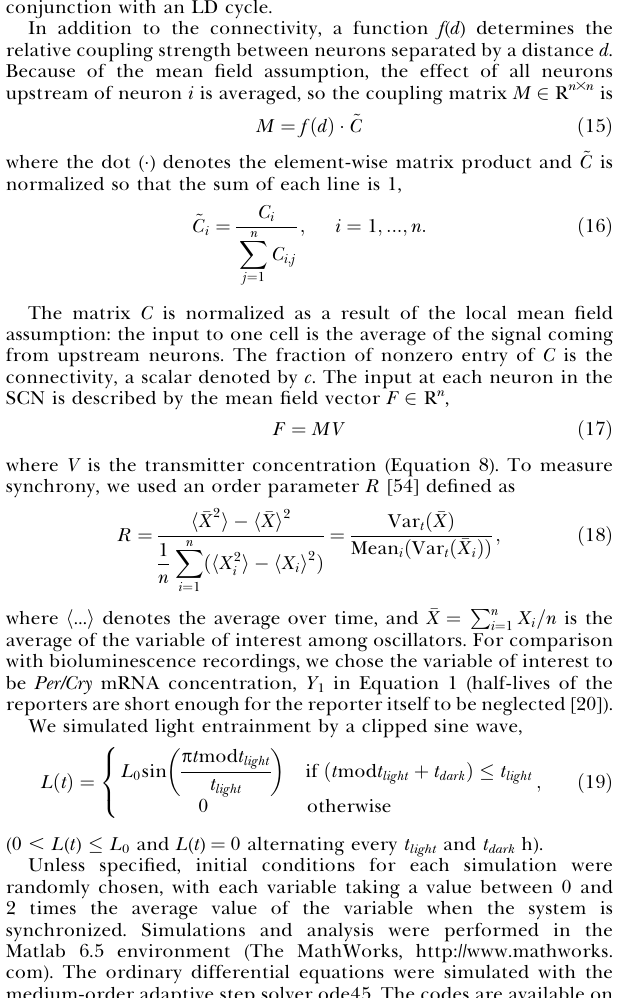
Figure S1. Coupling Matrices C for the Three Types of Coupling